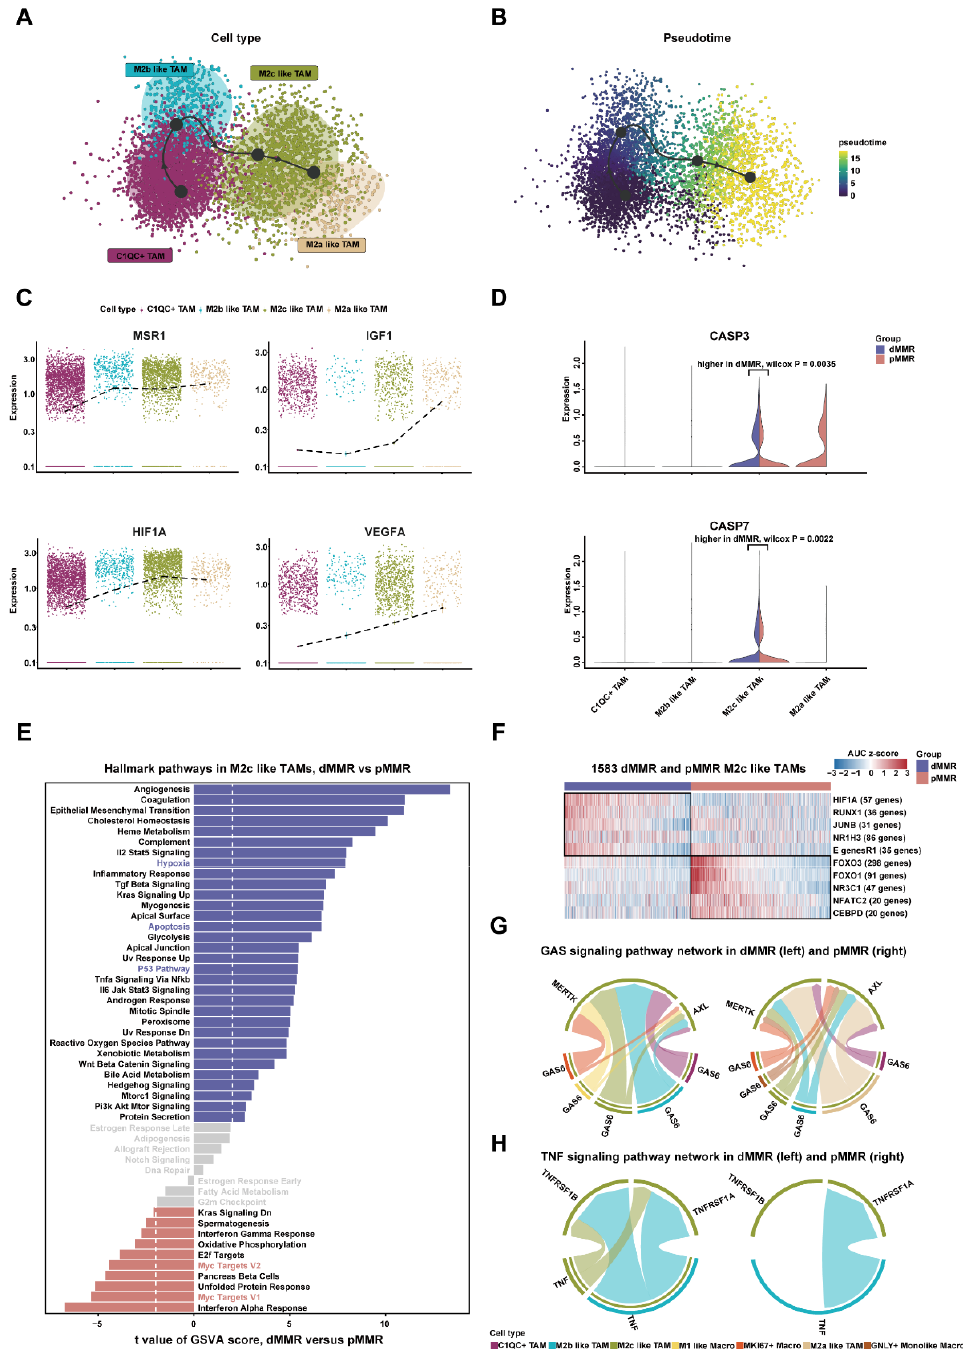
Figure 3. Pseudotime trajectories reveal that apoptosis results in different differentiation fates of M2c ‐ like TAMs: ( A ) pseudotime differentiation trajectory of M2 ‐ like TAMs; ( B ) pseudotime shows the direction of differentiation from C1QC+ TAMs to M2a ‐ like TAMs; ( C ) changes in the expression levels of MSR1, IGF1, HIF1A, and VEGFA with cell differentiation. The black dash indicates the average gene expression; ( D ) expression of apoptosis effector genes in subpopulations of M2 ‐ like